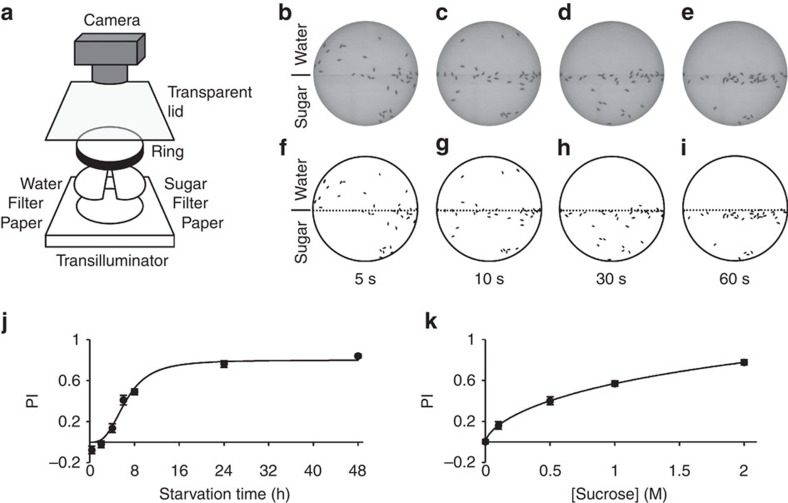
The sugar preference assay.(a) Schematic of the experimental set-up used to measure sucrose preference. (b–e) Examples of the distribution of starved (36 h) Canton S flies in the circular arena at various time points (5–60 s) after introduction. A 2-M sucrose solution was used for the sucrose side (lower semicircle). (f–i) Same images as in b–e after applying a suitable threshold with the Fiji software. Identified particles are in black. (j) Starvation dependency of sucrose PI of Canton S flies. A 2-M sucrose solution was used. n=8–12 per starvation interval. (k) Concentration dependency of sucrose PI of Canton S flies. Flies were starved to 20% mortality (average starvation time 40 h). n=11–15 per concentration. Results are means±s.e.m.